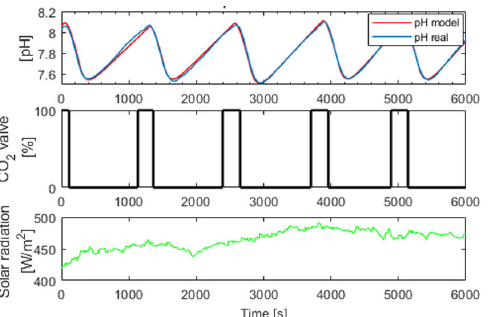
Figure 5. Thin-layer reactor model validation during daytime period. First graph represents the evolution of the real pH (blue) and the estimated pH (red). Second graph represents the valve opening, input for the model (black). Third graph represents the environmental global solar radiation disturbance (green). December